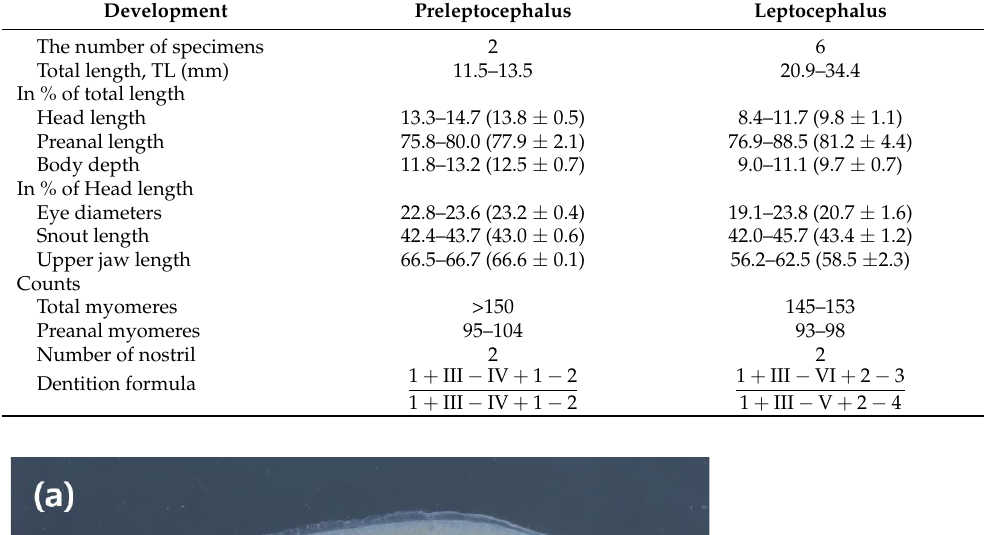
Table 3. Comparisons of measurements and counts for Muraenesox cineleus preleptocephali and leptocephali. Development Preleptocephalus Leptocephalus